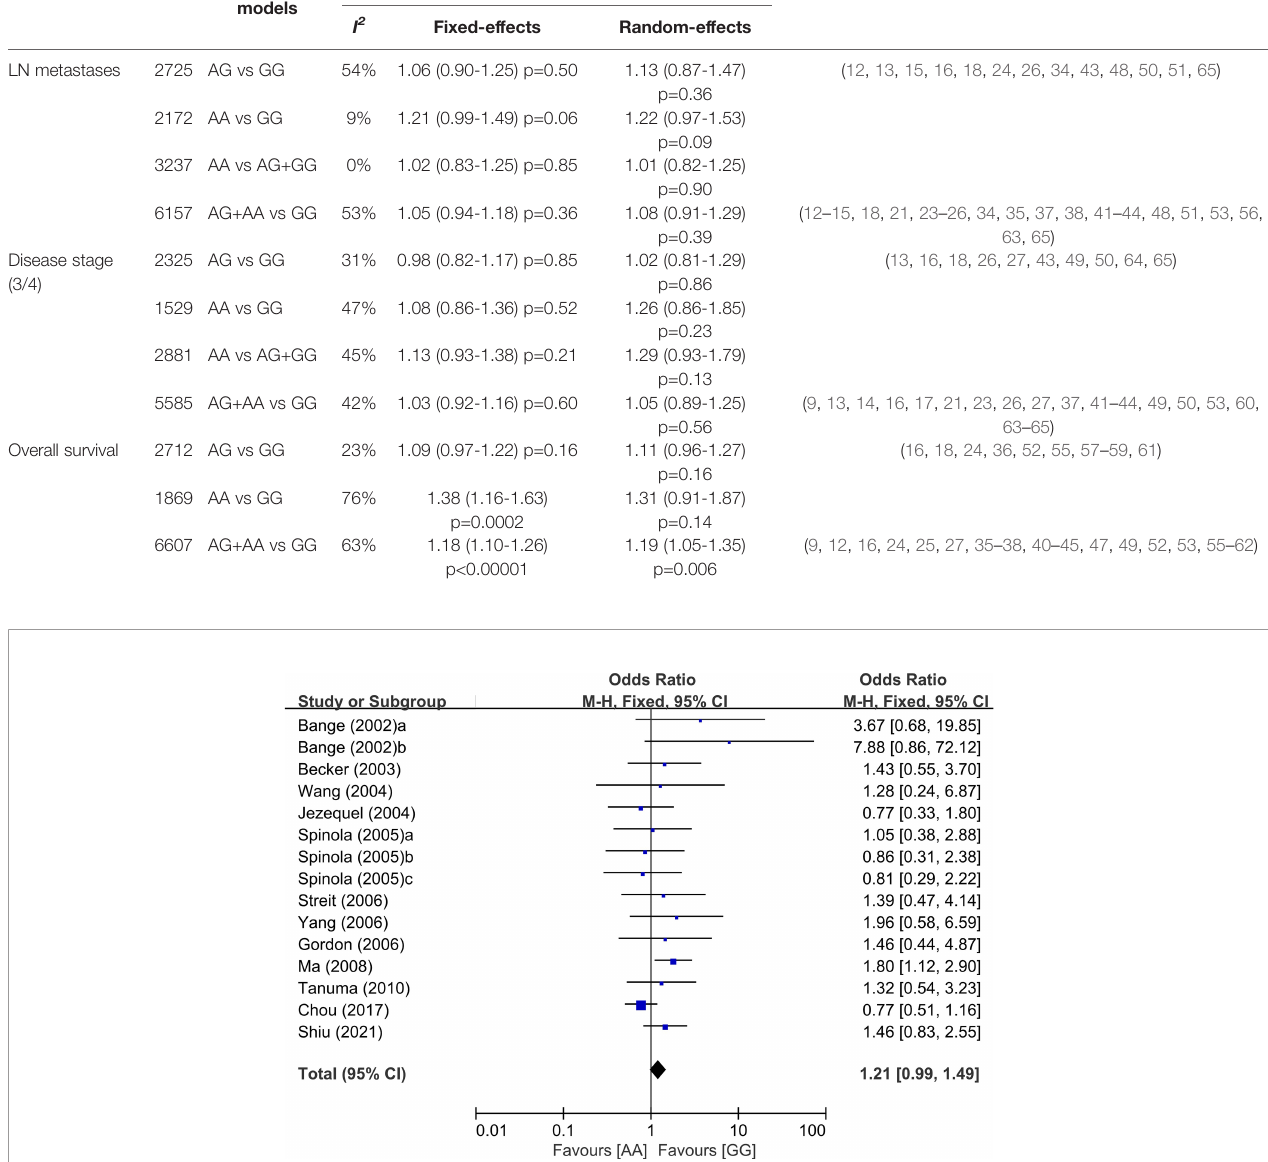
TABLE 2 | The meta-analyses of clinicopathological and prognostic parameters among the genetic models. n Genetic OR or HR (95% CI) models